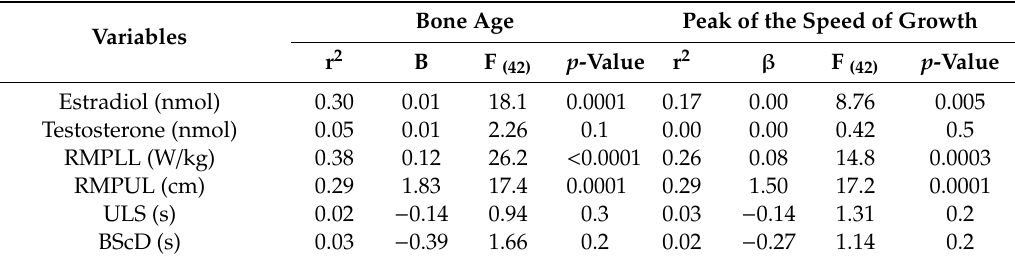
Table 5. Linear regression of the study variables with maturation. Variables